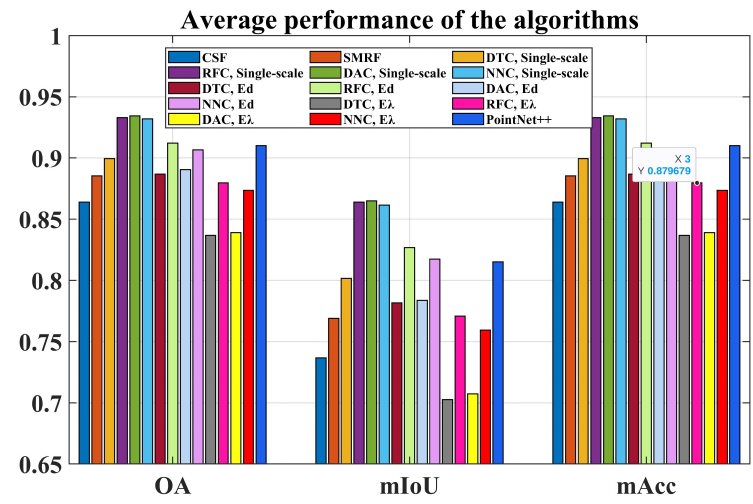
Figure 7. Classification results: OA, mIoU, mAcc.